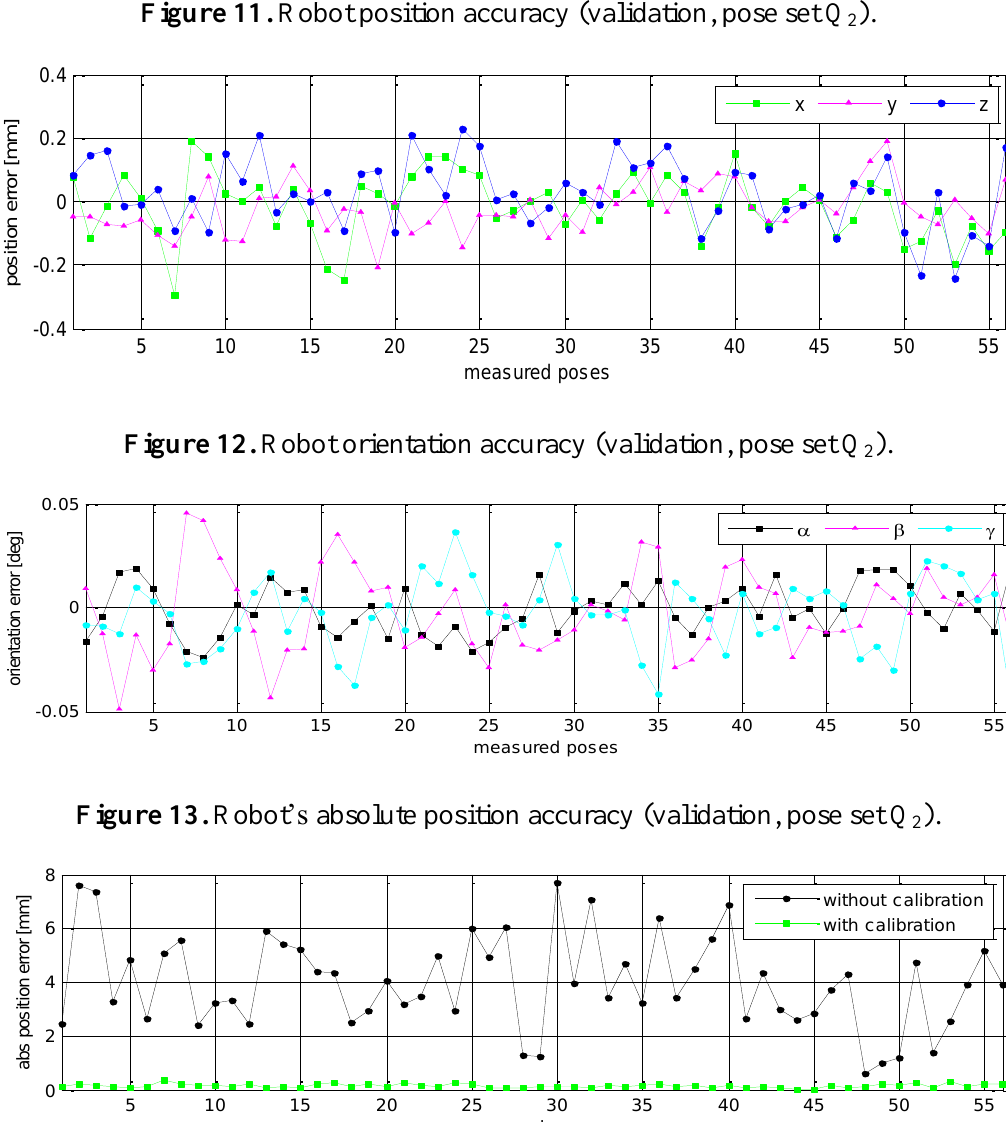
Figure 11. Robot position accuracy (validation, pose set Q